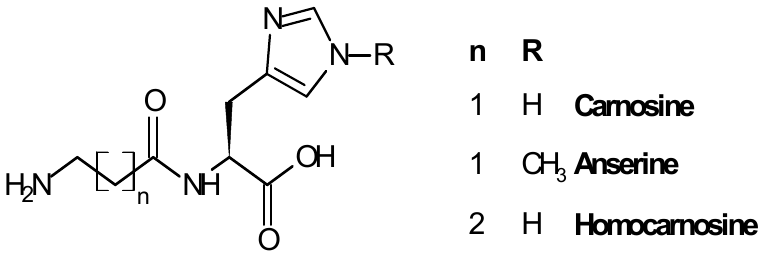
Figure 1. Structure of carnosine and related